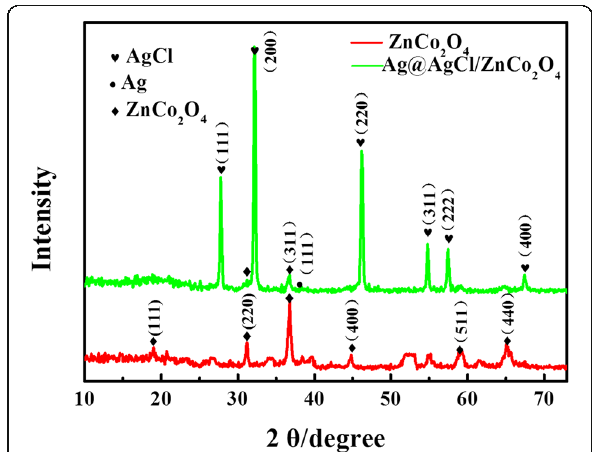
Fig. 1 The XRD patterns of the as-prepared ZnCo 2 O 4 and Ag@AgCl/ ZnCo 2 O 4 microspheres